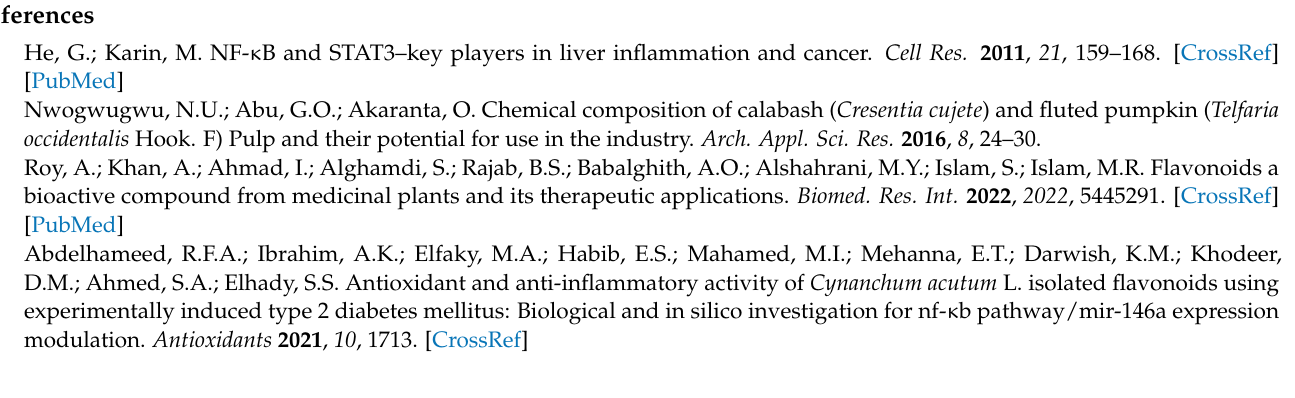
Table S2: Lipophilicity and water solubility; Table S3: Pharmacokinetics; Table S4: Drug Likeness; Table S5: Medical Chemistry; Table S6: Toxicity; Table S7: Molecular Docking Best scored ligand– protein complex data for all seven ligands with receptors 3V99, 4L9S and 3LN0; Table S8: Molecular Docking Best scored ligand–protein complex data for all seven ligands with receptors 1CB4, 2CAG and